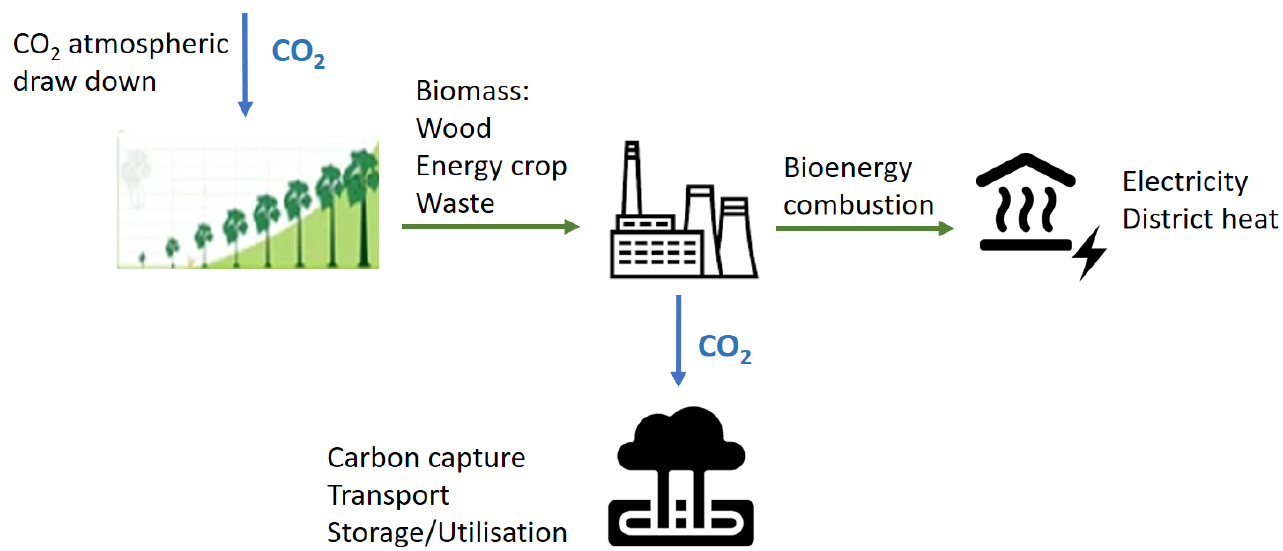
Figure 1. Bioenergy with carbon capture and storage (BECCS) technology. Source: own compilation based on [42].